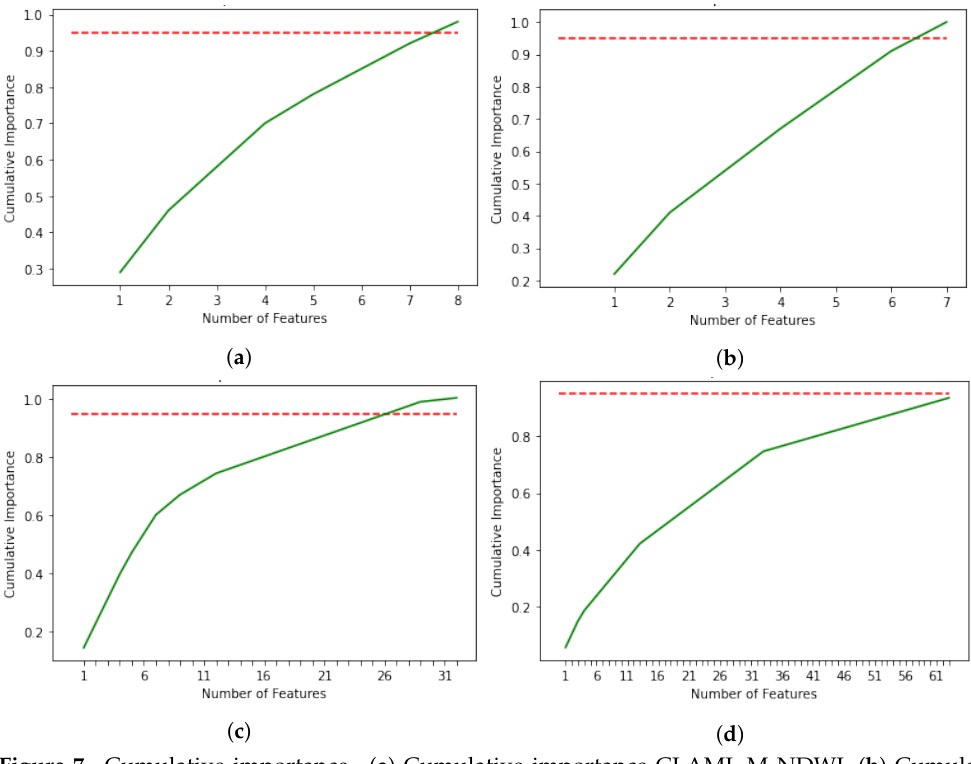
Figure 7. Cumulative importance. ( a ) Cumulative importance CLAML-M NDWI. ( b ) Cumula- tive importance CLAML-M NDVI. ( c ) Cumulative importance CLAML-TS NDWI. ( d ) Cumulative importance CLAML-TS